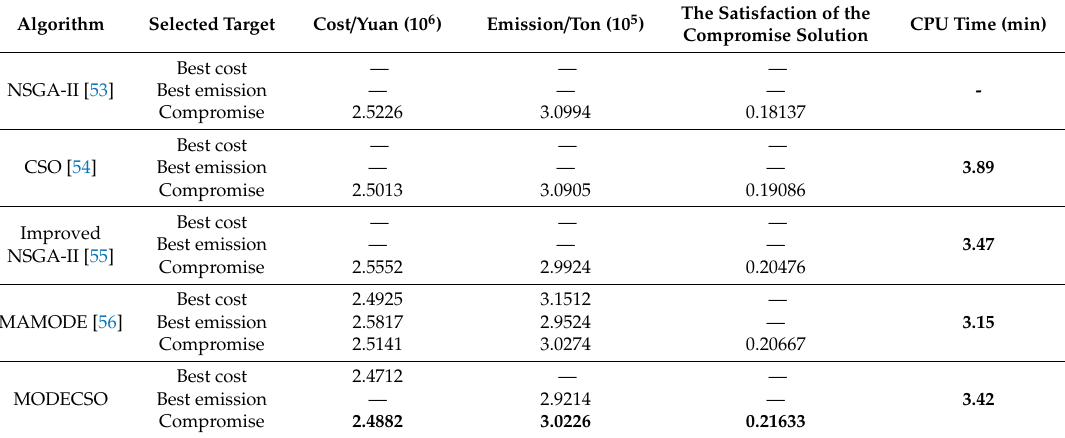
Figure 3. Comparison of results of different algorithms. Table 2. Specific results of several algorithms for solving DEED problem.